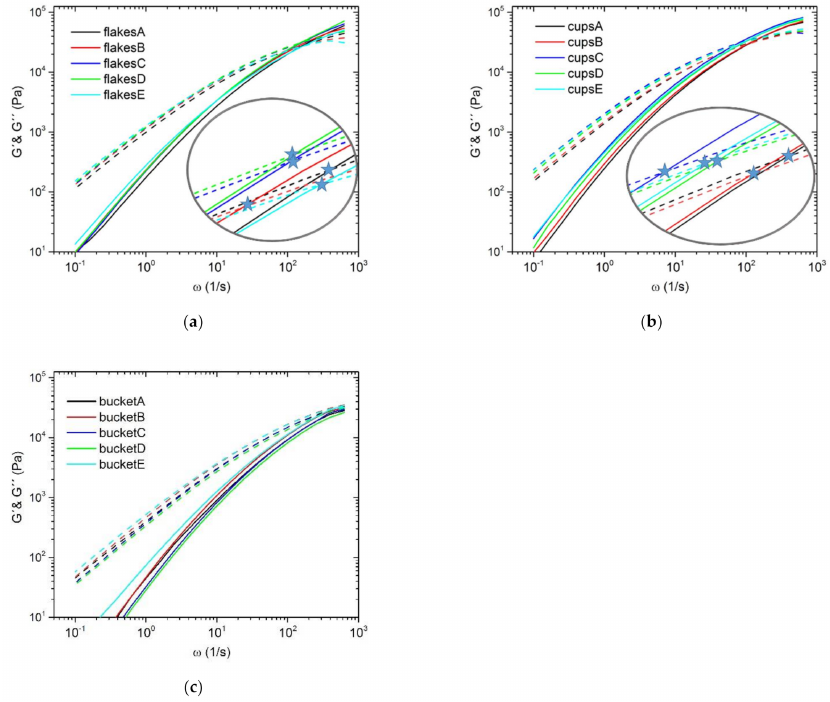
Figure 5. Storage modulus ( G (cid:48) ) lines and loss modulus ( G ”) dashed lines of the flakes ( a ), cups ( b ), bucket ( c ) and their blends; the stars represent the crossover point of the two curves ( G (cid:48) and G ”) of the respective blend series; measured at 230 ◦